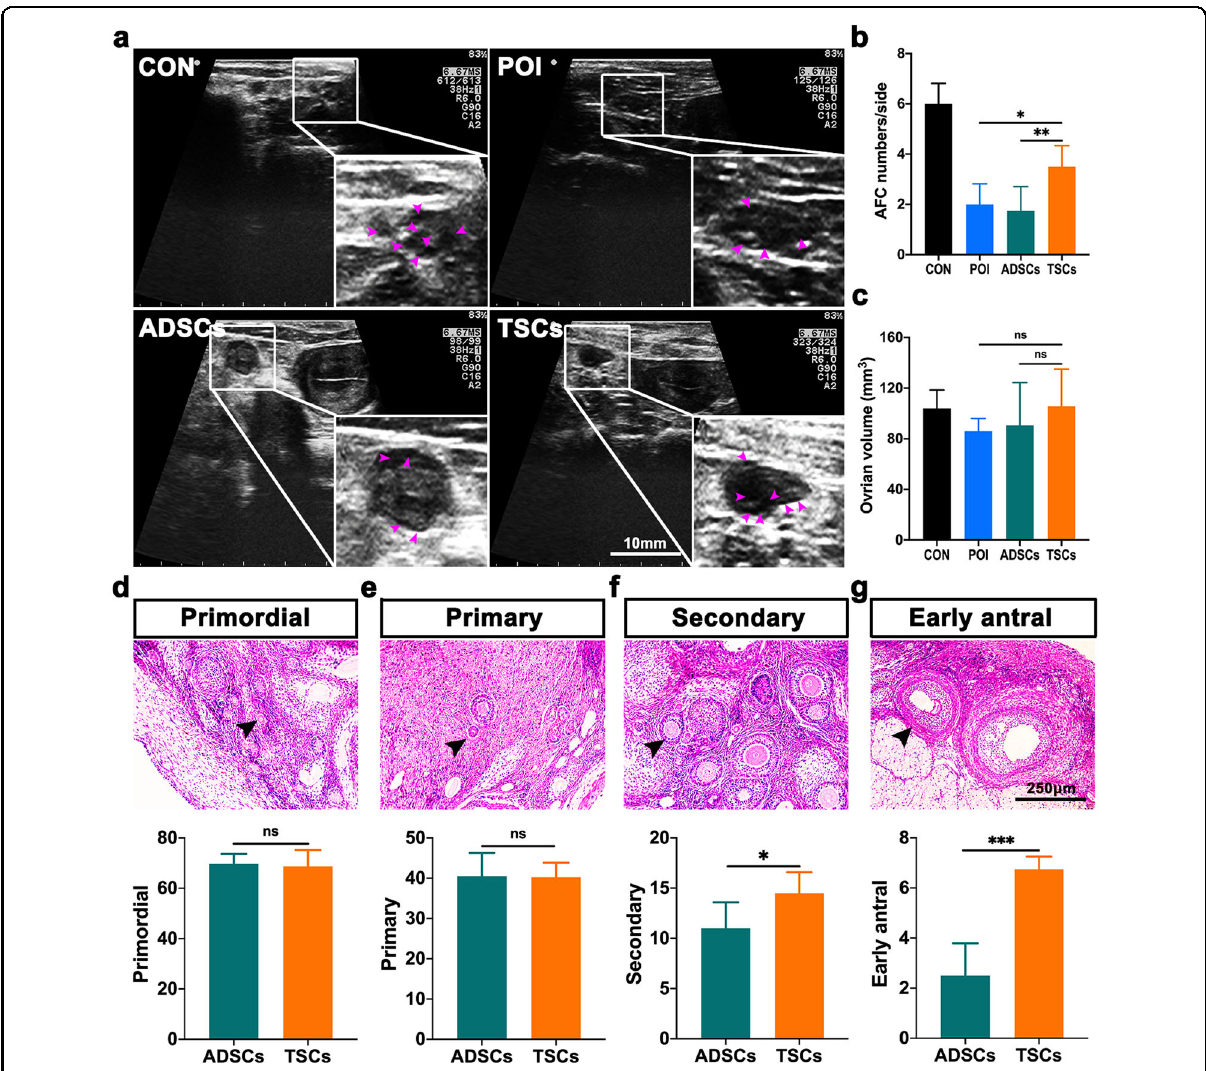
Fig. 4 TSCs transplantation was bene fi cial to the development of AFC. a B-ultrasound observation of ovarian development and statistics of early antral count (AFC) (purple arrow refers to the AFC, diameter ≥ 2 mm) after TSCs transplantation. b Statistics of the number of AFCs. c Statistics of the ovarian volume. d The number of primordial follicles (indicated by the black arrow). e The number of primary follicles (indicated by the black arrow). f The number of secondary follicles (indicated by the black arrow). g The number of early antral follicles (indicated by the black arrow). (Compare to control, n = 4). The CON group represents the normal wild-type monkeys ( n = 4), the POI group represents the monkeys with premature ovarian failure ( n = 4), the ADSCs group represents the monkeys with POI that received adipose-derived mesenchymal stem cells transplantation (ADSCs = POI + ADSCs, n = 4); and the TSCs group represents the monkeys with POI that received thecal stem cells transplantation (TSCs = POI + TSCs, n = 4). Data are expressed as the means ± SEM and signi fi cance were determined by one-way ANOVA or t -test. * P < 0.05, ** P < 0.01, ns not signi fi cant; * P < 0.05, ** P < 0.01, *** P < 0.001, ns not signi fi